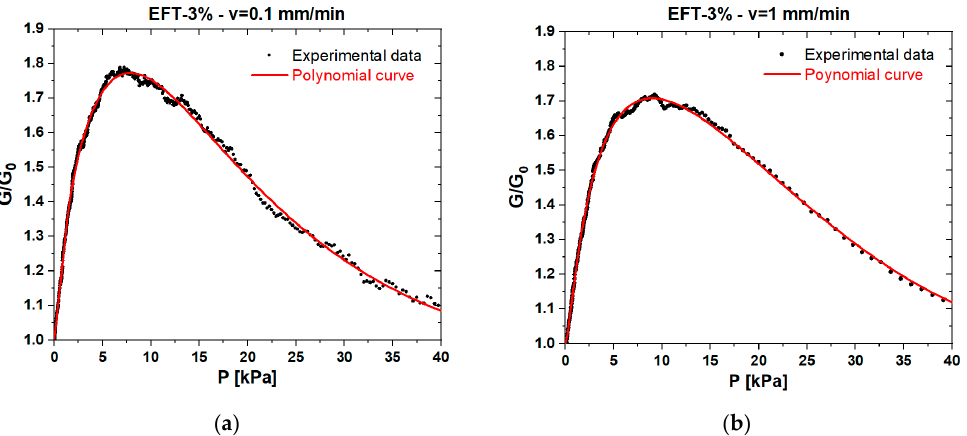
Figure 11. Normalized conductance vs. pressure and corresponding polynomial fitting curves obtained at a speed of 0.1 ( a ) and 1 ( b ) mm/min for the EFT-3% sample.